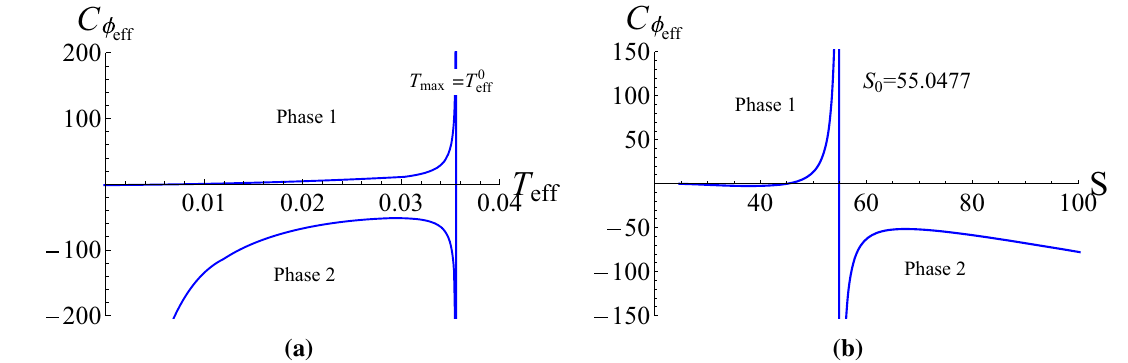
Fig. 9 Heat capacity C φ varying with effective temperature T eff and entropy S , for the case of k = 1, φ eff = 0 . 2 and q = − 0 . 2. Note the phase eff transition of ECBH spacetime occurs when the effective temperature is less than T 0